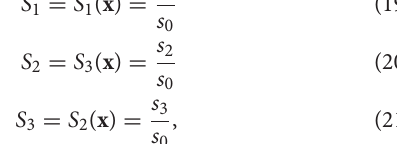
Frontiers in Physics |